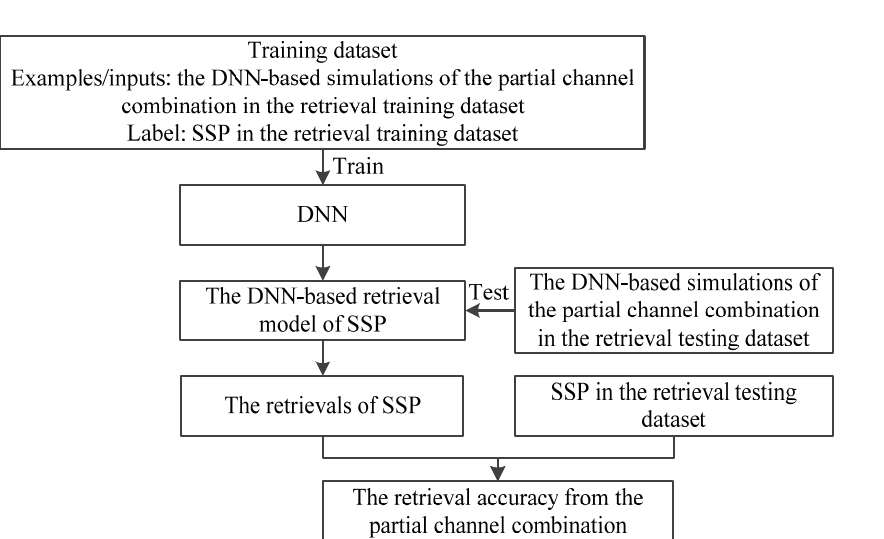
Figure 4. The schematic of obtaining the retrieval accuracy from the partial channel combination. Experiment 4: The retrieval experiments of SSP based on MWTS-II observed bright- ness temperatures. From the perspective of practical retrieval applications, it is necessary